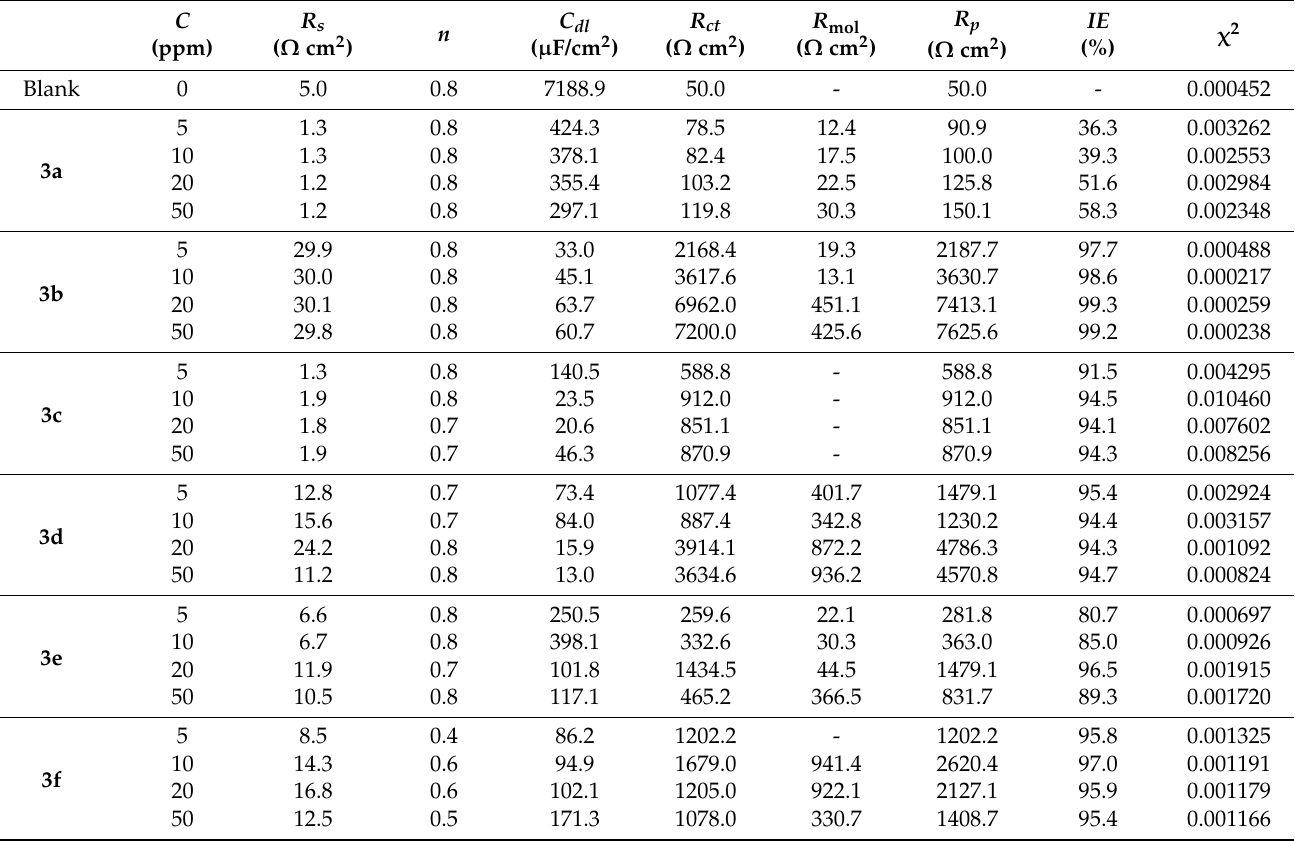
Table 1. Electrochemical parameters of 1- N - α - D -glucopyranosyl-1 H -1,2,3-triazole xanthine as corro- sion inhibitor in API 5L X70 steel immerse in HCl 1